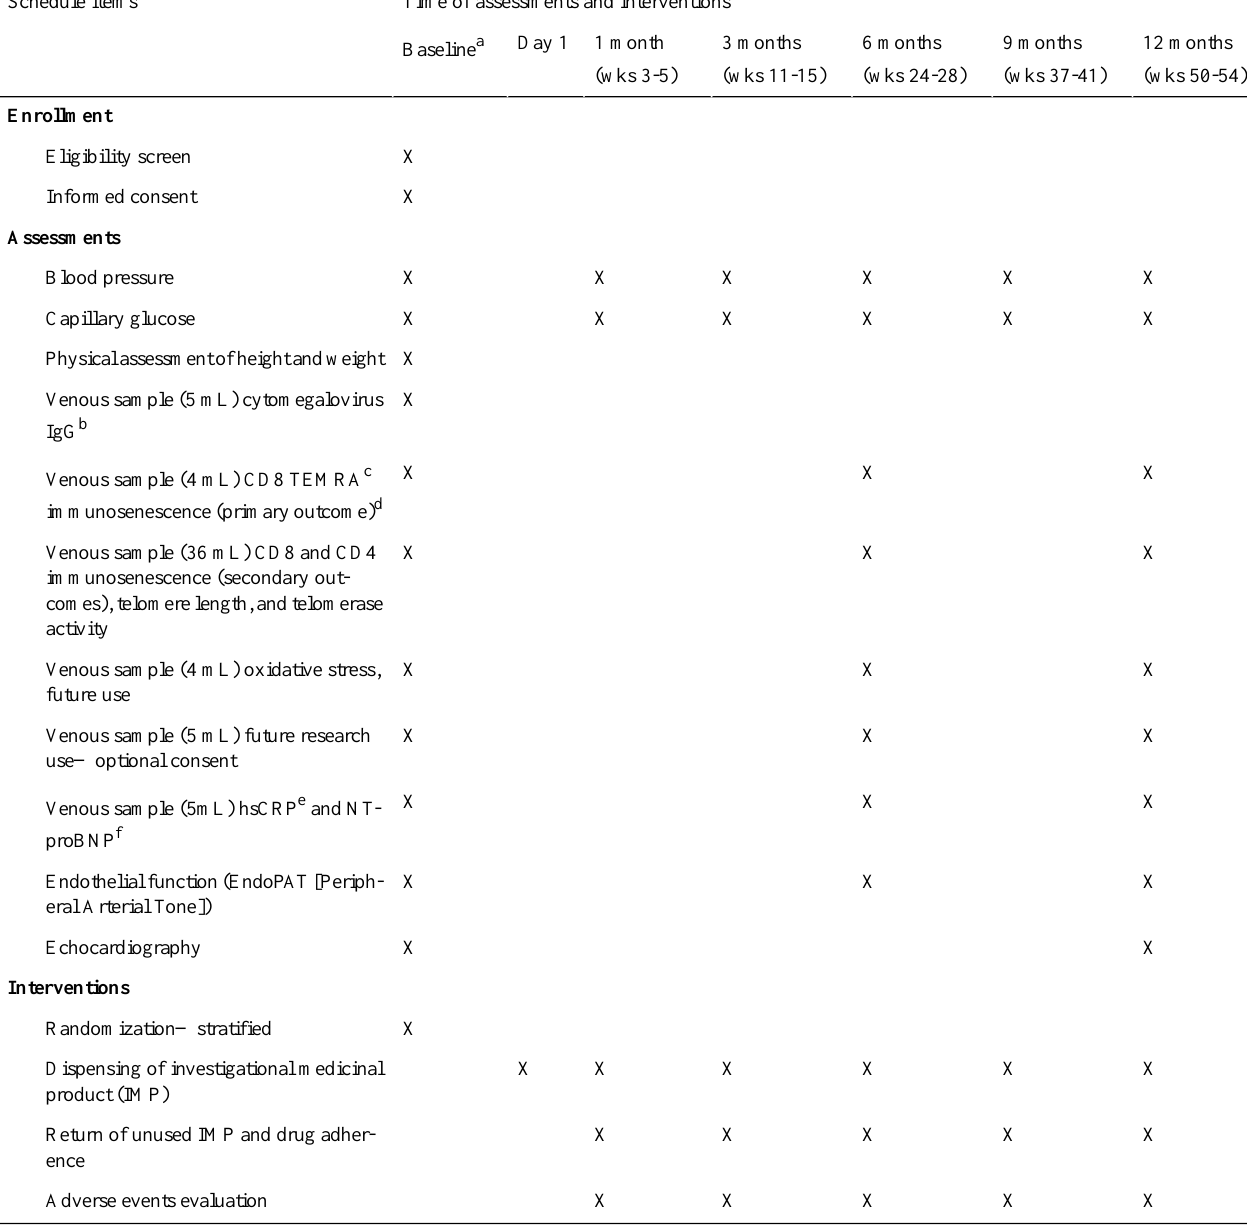
Time of assessments and interventionsSchedule items